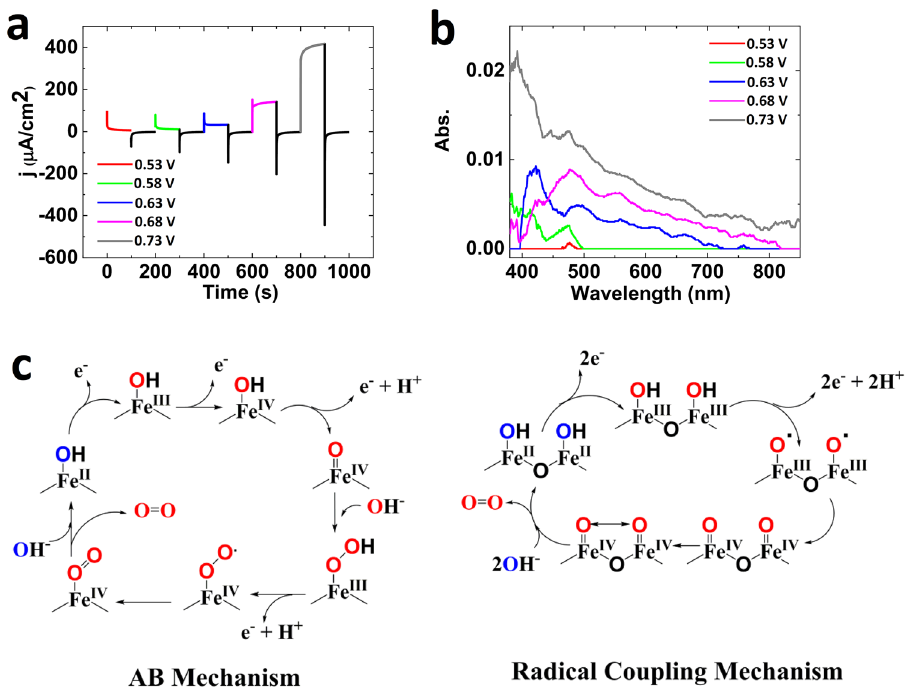
Figure 5. Operando high-resolution visible spectroscopy for Fe oxide covered FTO as working electrode ( a , b ) in KOH (pH 14). Each amperometry and its related high-resolution visible spectroscopy is in the same color (see Fig. S4 for setup). Two schematic proposed mechanisms for OER by Fe oxide under alkaline conditions ( c